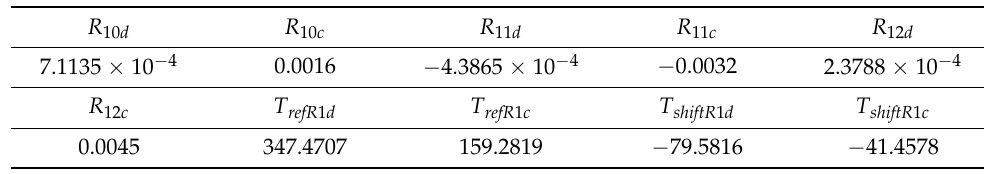
Table A1. Parametric R 1 Function Parameters.